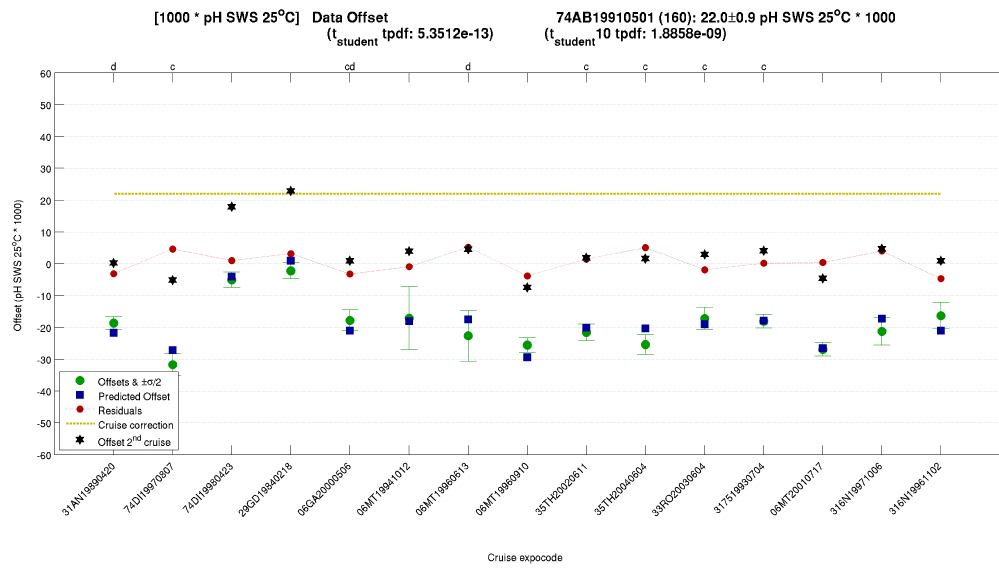
Figure 18. Cruise crossover information plot for 74AB19910501 (160).